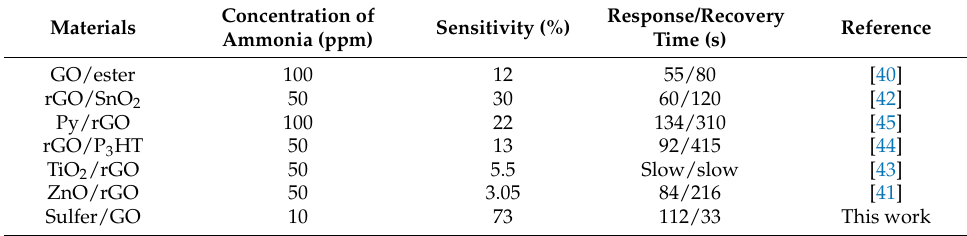
Table 3. NH 3 -sensing performance of graphene-based sensors at room